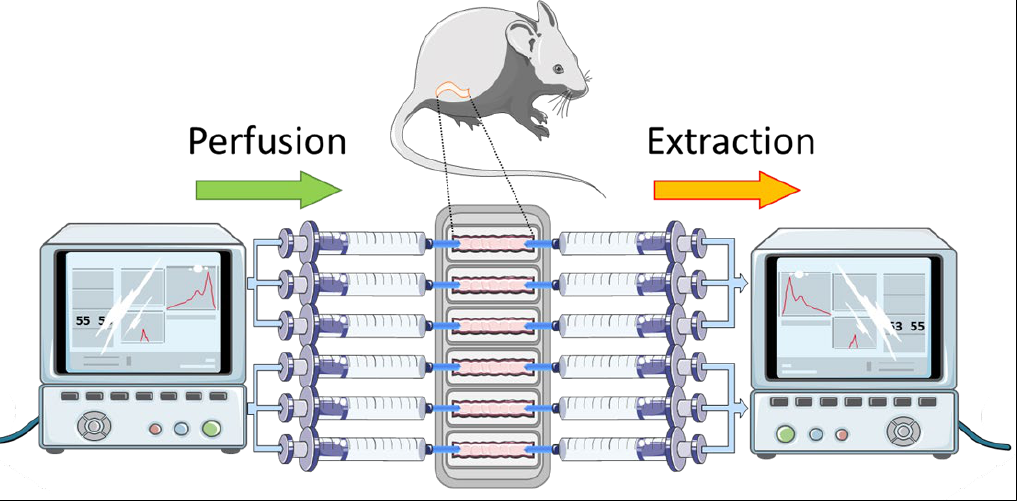
Figure 1. Gut-Ex-Vivo System—GEVS—and IBD induction. Schematic representation of a GEVS, in which mouse colon is cultivated in a dynamic condition and stimulated for 5 h with DNBS, to stimulate the onset of UC [3].